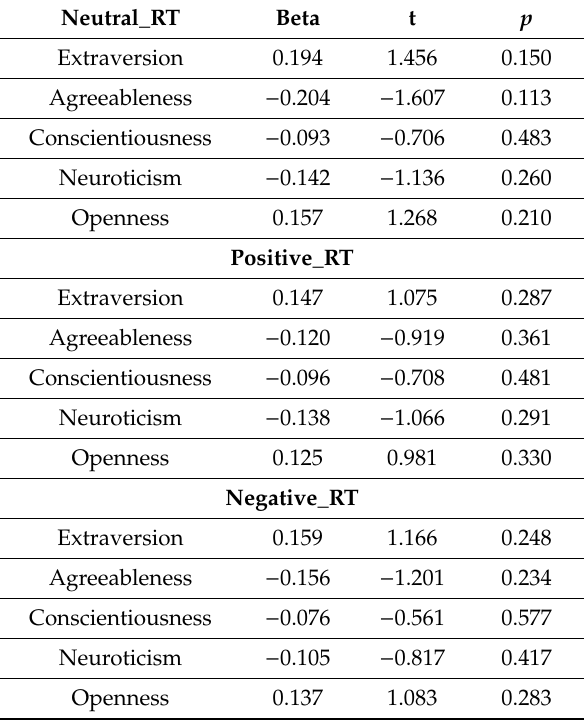
Table A3. Regression analysis—the direct e ff ect of personality variables and Stroop